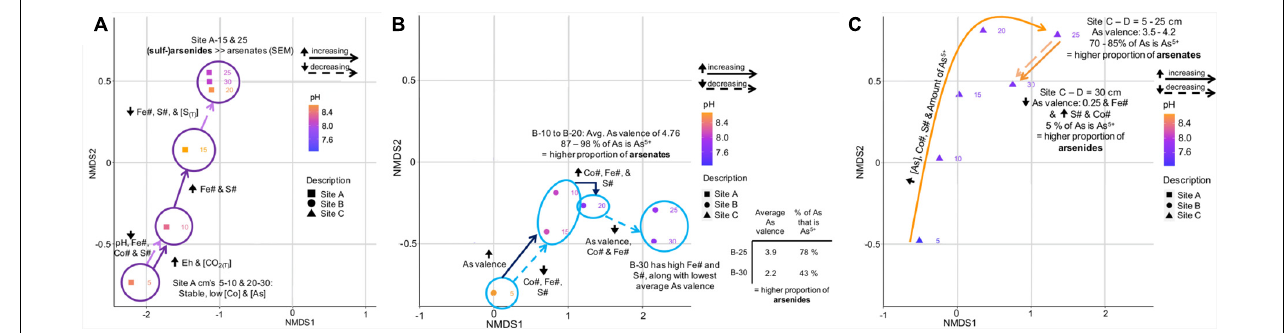
FIGURE 9 | Annotated NMDS plots showing the variation in important environmental and geochemical parameters on the microbial community composition of tailings from site A (A) , site B (B) , and site C (C) . (B) has an additional inlet showing the average valence of As and the percent of As that is As 5 + at D = 25 and 30